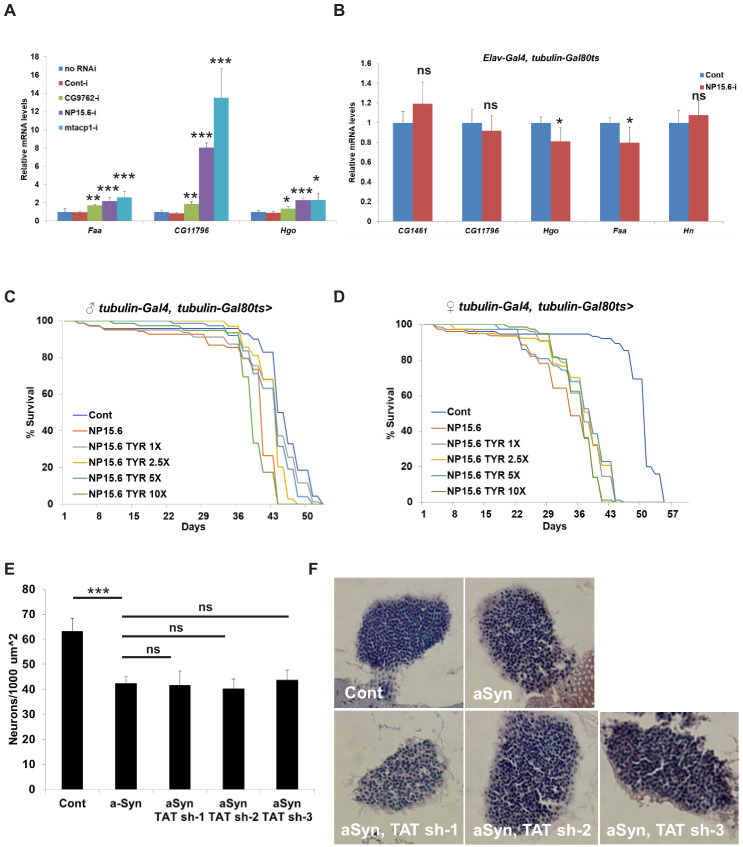
Suppression of complex I of ETC upregulates mRNA levels of enzymes in the tyrosine degradation pathway and decreases lifespan that can be partially rescued by supplementation of tyrosine.(A) Relative mRNA levels of Faa, CG11796, Hgo in tubulin-Gal80ts, tubulin-Gal4 flies expressing either no RNAi, control RNAi or RNAi against different subunits of mitochondrial ETC Complex I – CG9762, NP15.6, mtacp1 for 10 days. Means ± SD. (B) Relative mRNA levels of CG1461/TAT, CG11796, Hgo, Faa, and Hn in tubulin-Gal80ts, elav-Gal4 flies expressing either control RNAi or RNAi against NP15.6. Lifespans of male (C) and female (D) tubulin-Gal80ts, tubulin-Gal4 flies expressing either control RNAi or RNAi against NP15.6 fed with the range of tyrosine concentrations (1X = 0.5 g/L). Neuronal counts (E) and histology (F) of hematoxylin-stained heads from flies with or without expression of wild-type human α-synuclein with or without three different RNAi against TAT. Means ± SD. *p<0.05, **p<0.01, ***p<0.001.